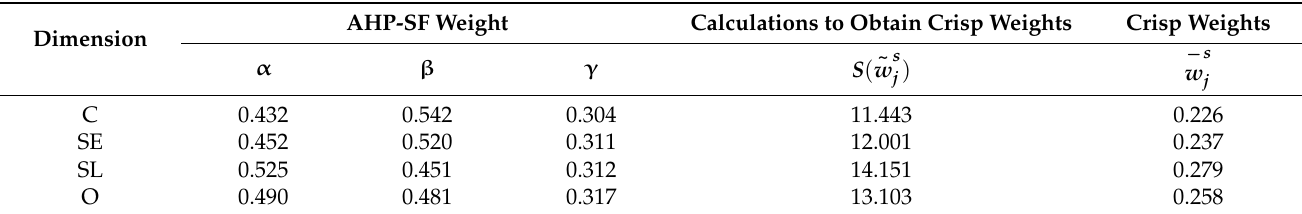
Table 11. The spherical weights from the AHP-SF